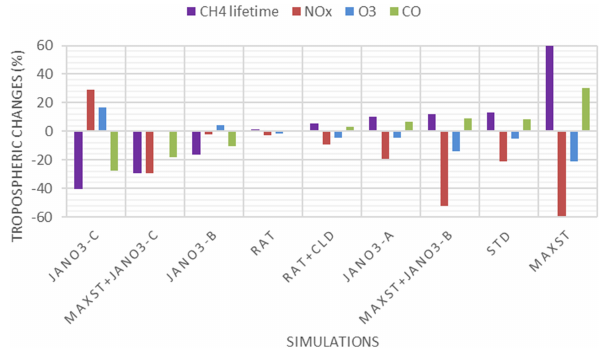
Figure 16. Calculated global-mean changes of tropospheric abun- dances in additional simulations compared to the OLD case (with- out HONO chemistry). From left to right, the order of shown sim- ulations follows the percentage change magnitudes in CH 4 lifetime (largest negative change to largest positive change; purple bars). Other bars show percentage changes in NO x (red), O 3 (blue), and CO